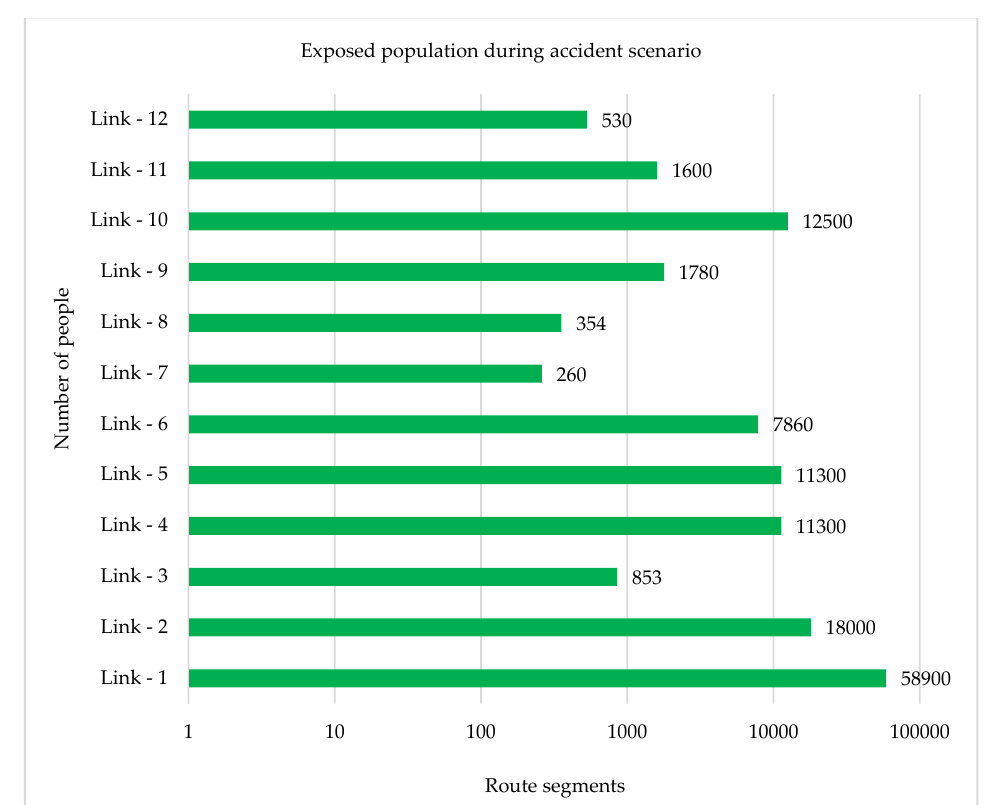
Figure 4. Accident transport result of monazite (NORM).